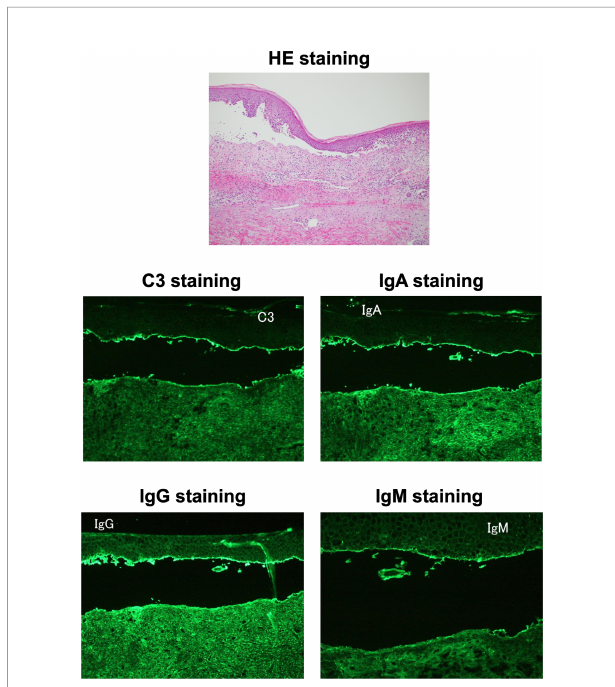
FIGURE 1 | Histopathological microscopic fi ndings on skin biopsy. The hematoxylin and eosin staining of the skin biopsy (upper panel) showed a sub-epidermal cleavage. C3, Immunoglobulin (Ig) G, IgA and IgM staining (middle and lower panels) showed linear deposit at the membrane zone,